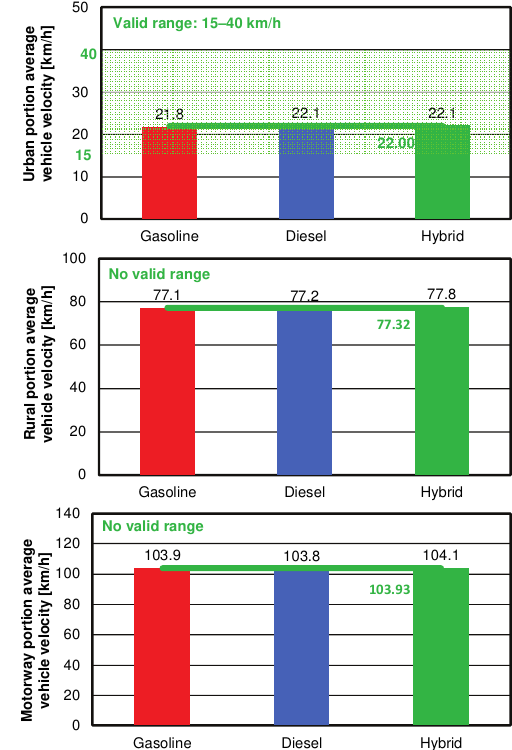
Fig. 8. Average vehicle speed comparison of urban (a), rural (b) and motorway (c) test drives with the minimum speed (required) and the mean value for all